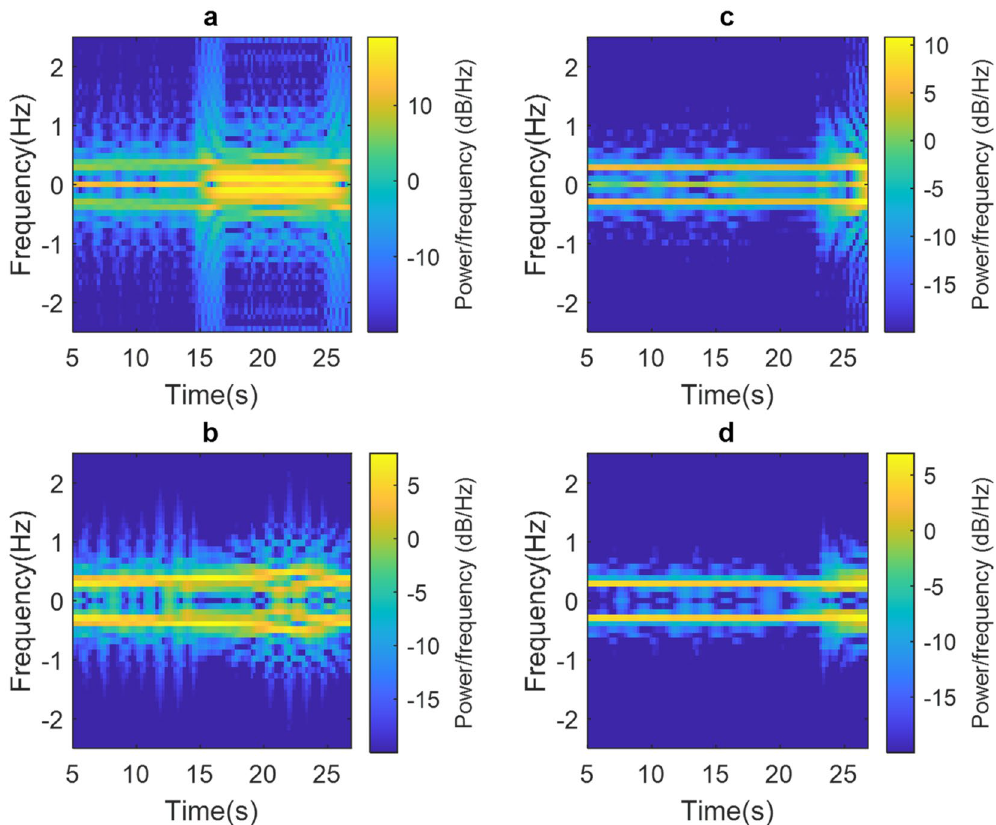
Figure 5. ( a ) Non-corrected spectrogram and ( b ) corrected spectrogram for head movement at 15 s and ( c ) uncorrected spectrogram and ( d ) correction spectrogram for head movement at 25